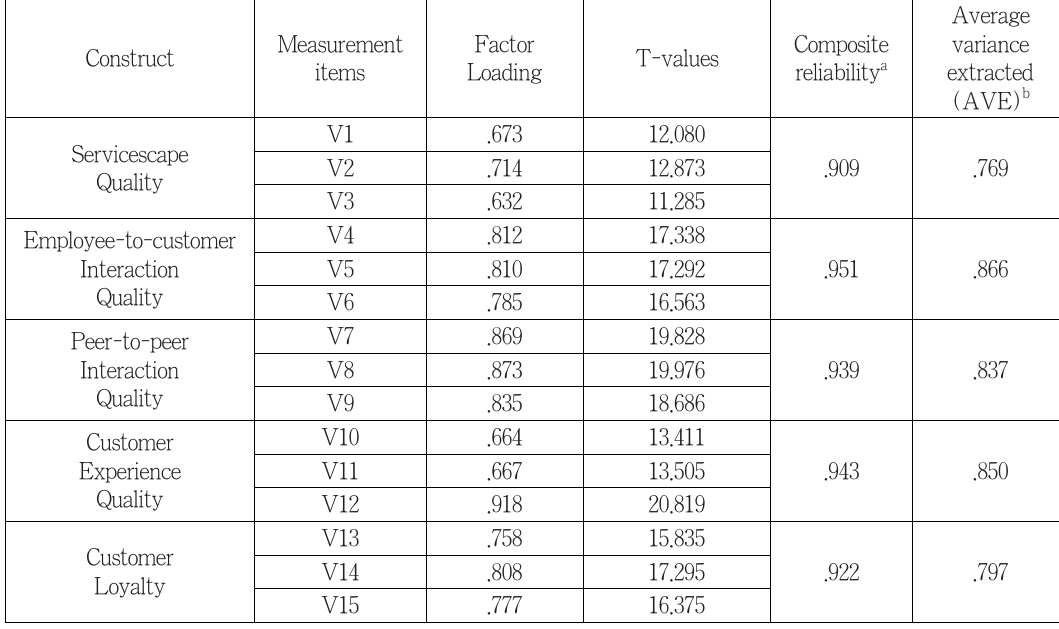
<Table 2> Summary of measurement